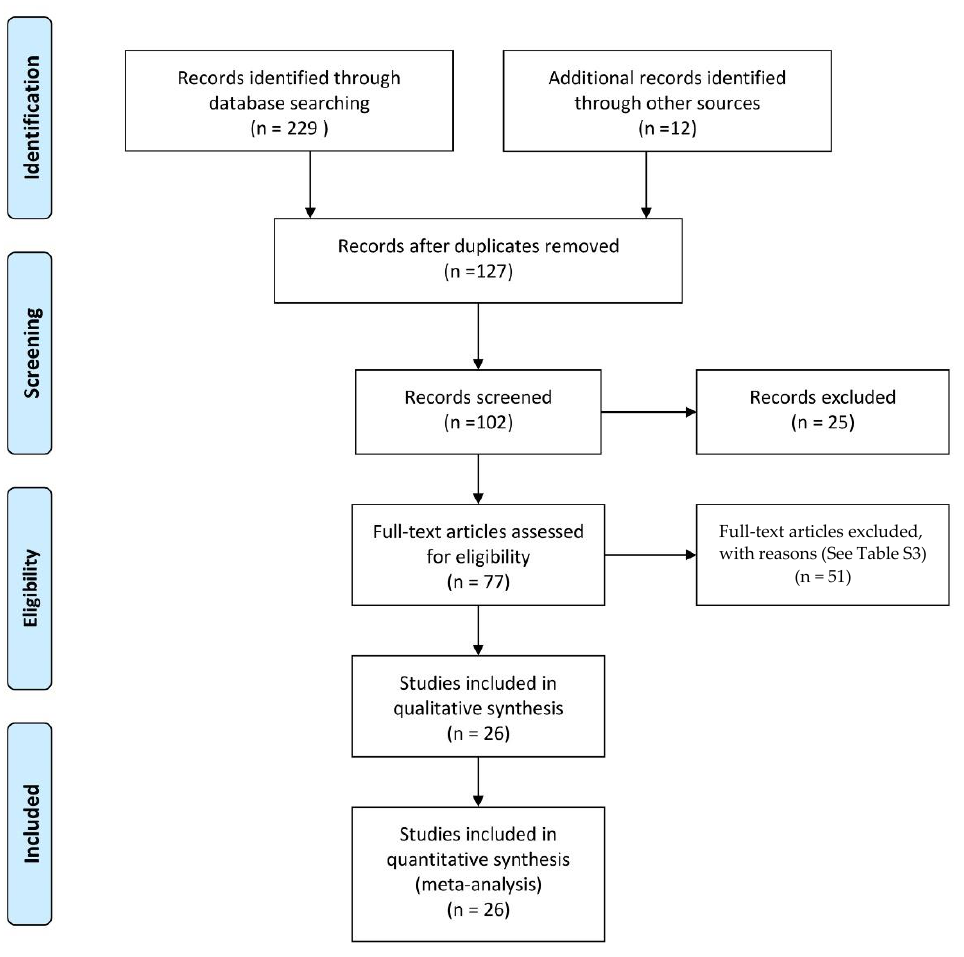
Figure 1. Flow diagram of the search strategy and study selection. Twenty-nine different probiotic comparisons were analysed; 21 were combinations of Bifidobacteria and 8 of Lactobacilli. (Supplemental Table S1) The evaluation of the quality of the evidence and the reasons for excluding the articles are included in Supplemental Tables S2 and S3. A total of 1898 and 1957 children, one day to 36 months old, were as- signed to placebo vs probiotic or probiotics/prebiotic infant formula, respectively. The mean duration of the interventions was 5.6 ± 2.84 months (3 to 12 months). Details of the included studies are reported in Table 1. Table 1. The main characteristics of the randomised controlled trials were included in the network meta-analysis.